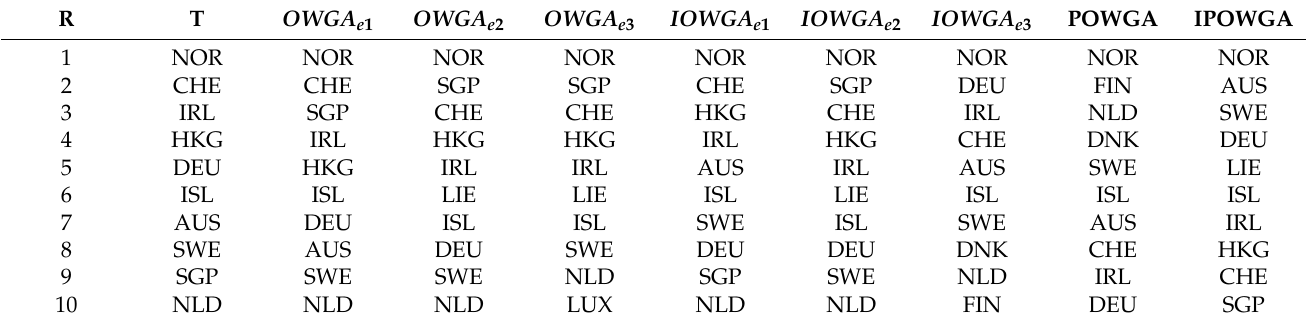
Table 3. Top 10 countries.